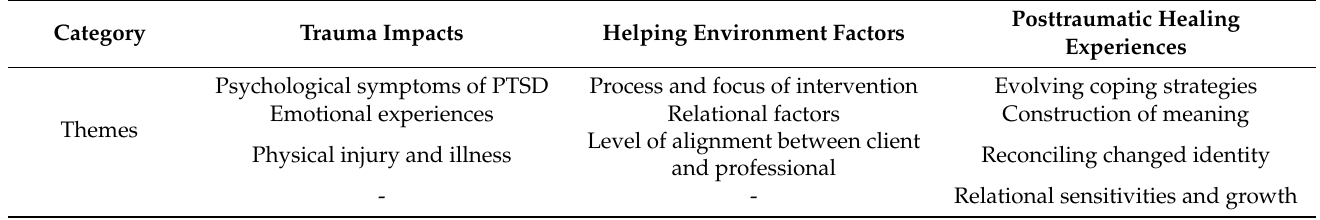
Table 1. Themes and